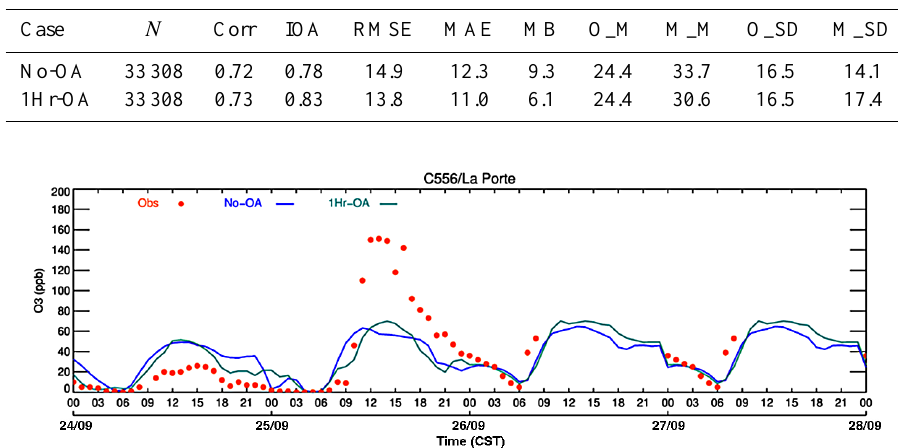
Table 4. Statistics of ozone for CMAQ simulations; see Table 3 for column header information.